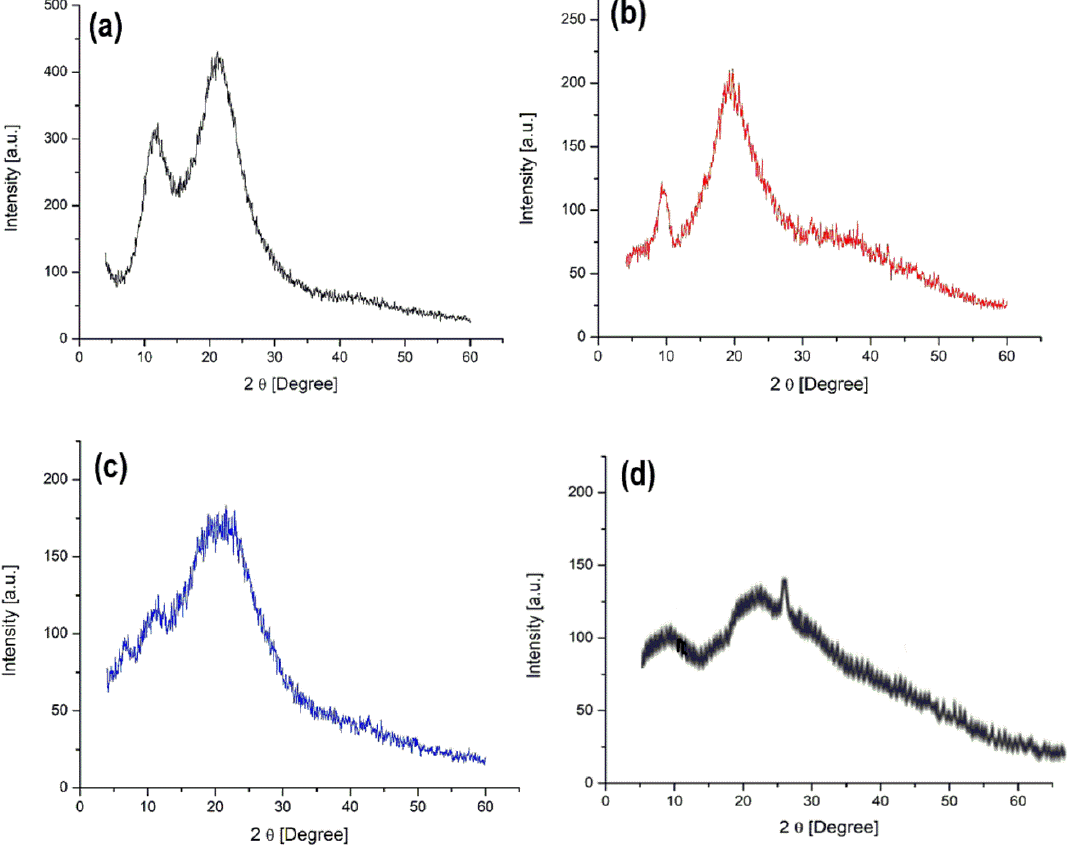
Figure 12. XRD patterns of PNVI ( a ); GLL ( b ); PG ( c ) and PGB1 samples ( d ).